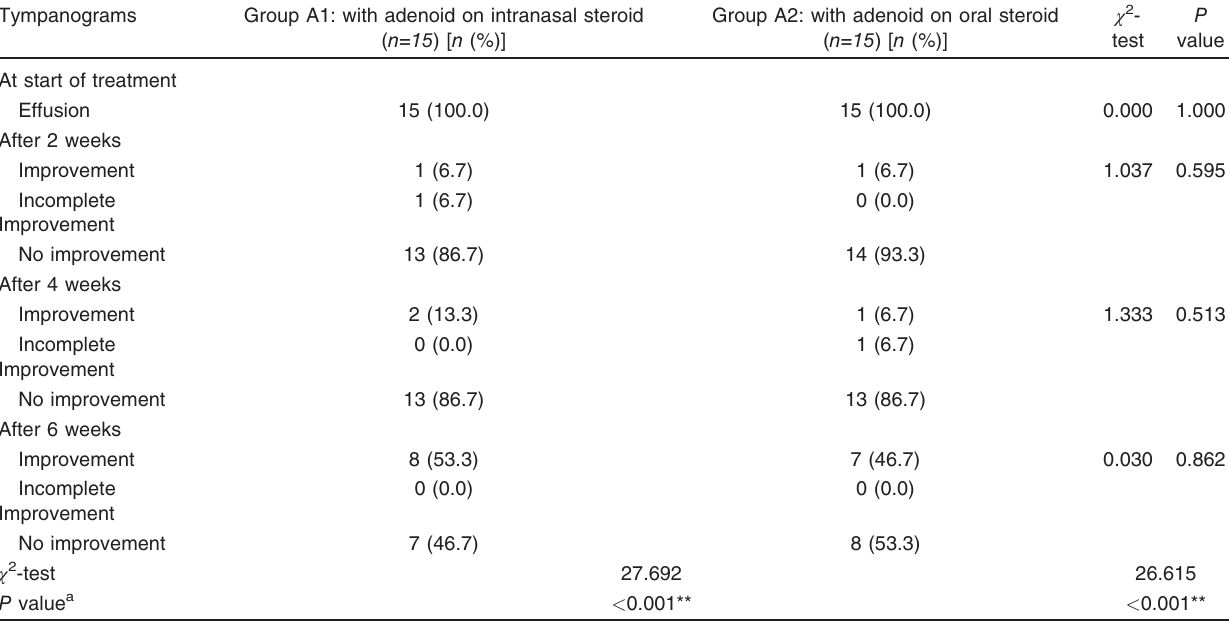
Table 7 Comparison between group A1, with adenoid on intranasal steroid, and group A2, with adenoid on oral steroid according to tympanograms